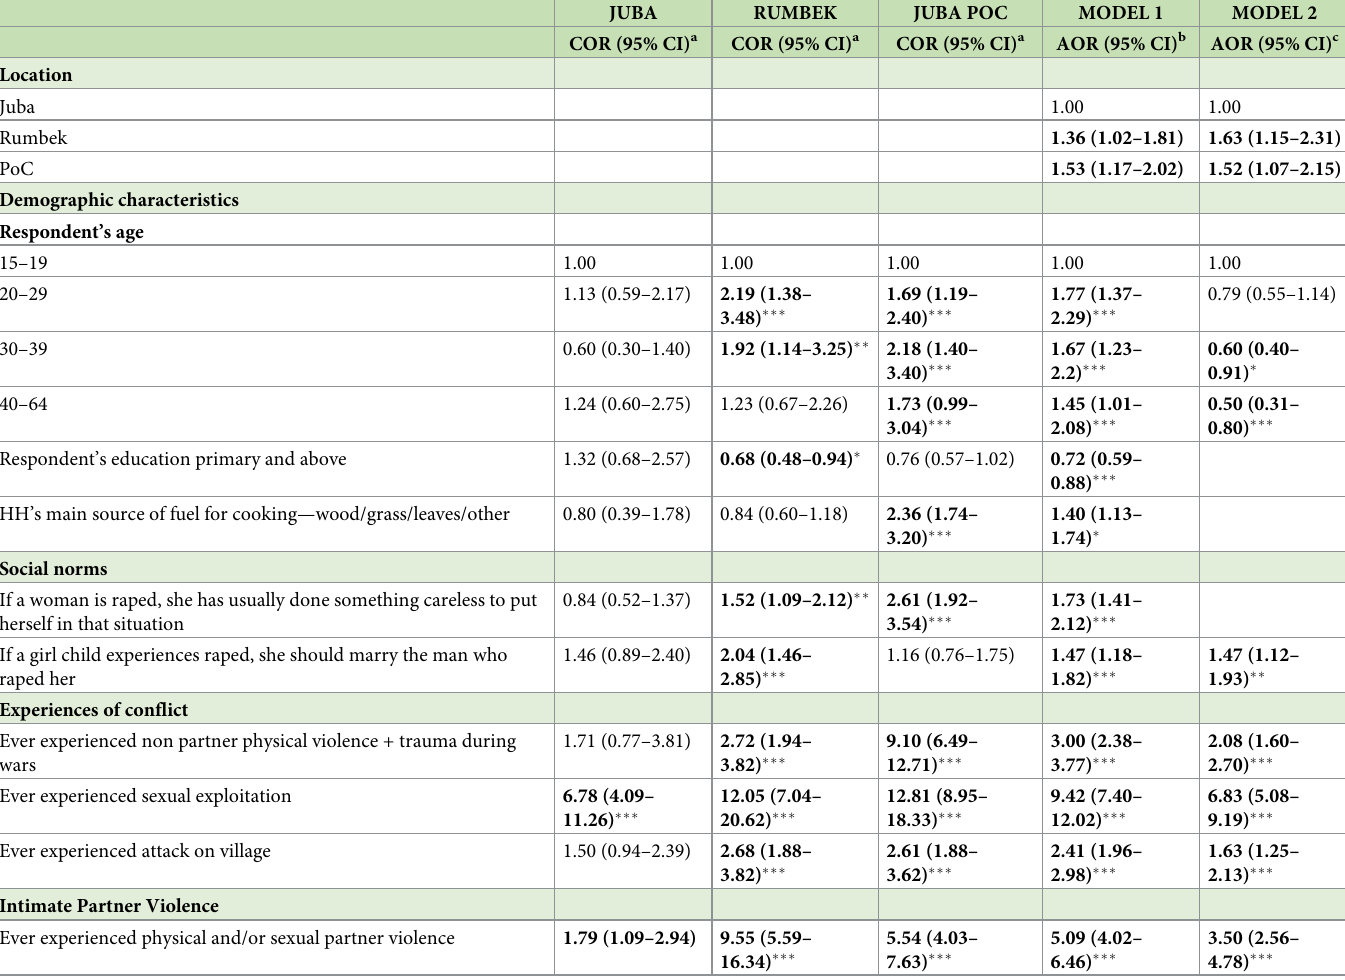
Table 7. Risk factors for non-partner sexual